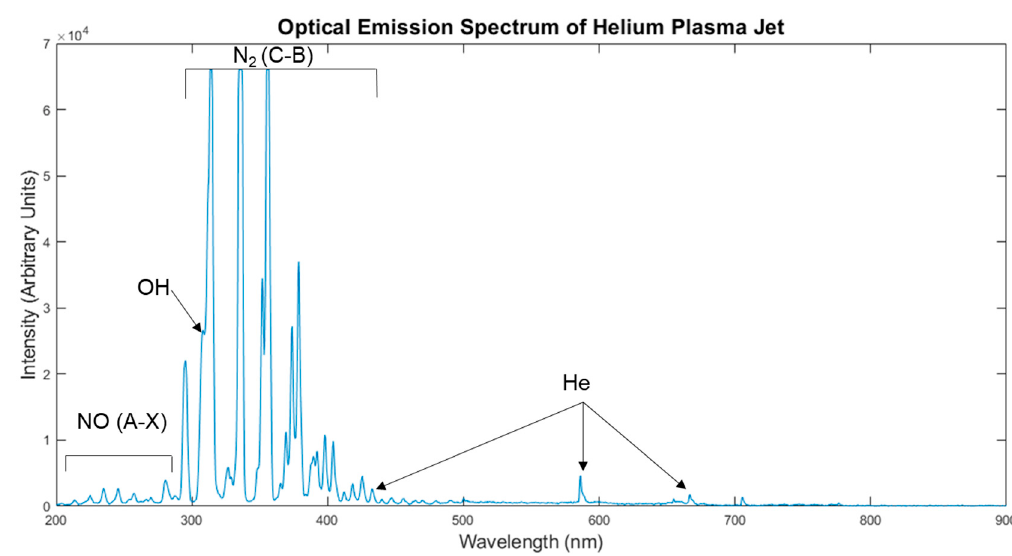
Figure 5. The spectrum emitted from the plasma discharge.